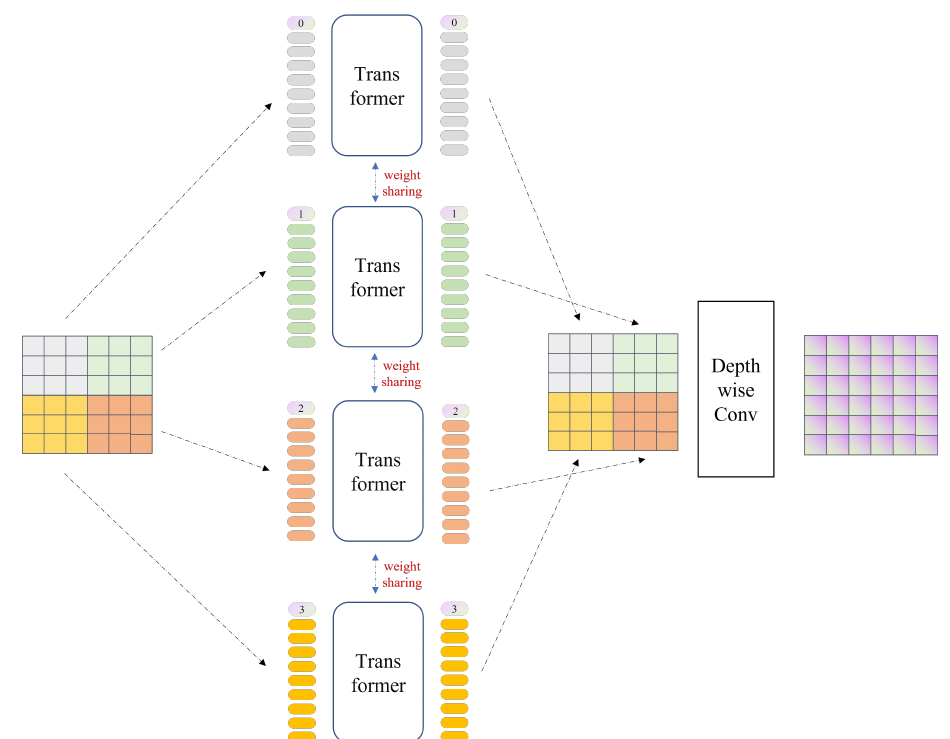
Figure 5. Local aggregation module’s structure. The input image features are first to split into different patches, then the corresponding memory tokens are queried from the global branch and appended as a token along with the features. All the patches are passed through a transformer encoder for feature extraction. These features are reshaped back to image grids and fed into a depthwise convolution layer for local feature alignment. Note that the weight sharing strategy is used in all transformers for parameter efficiency